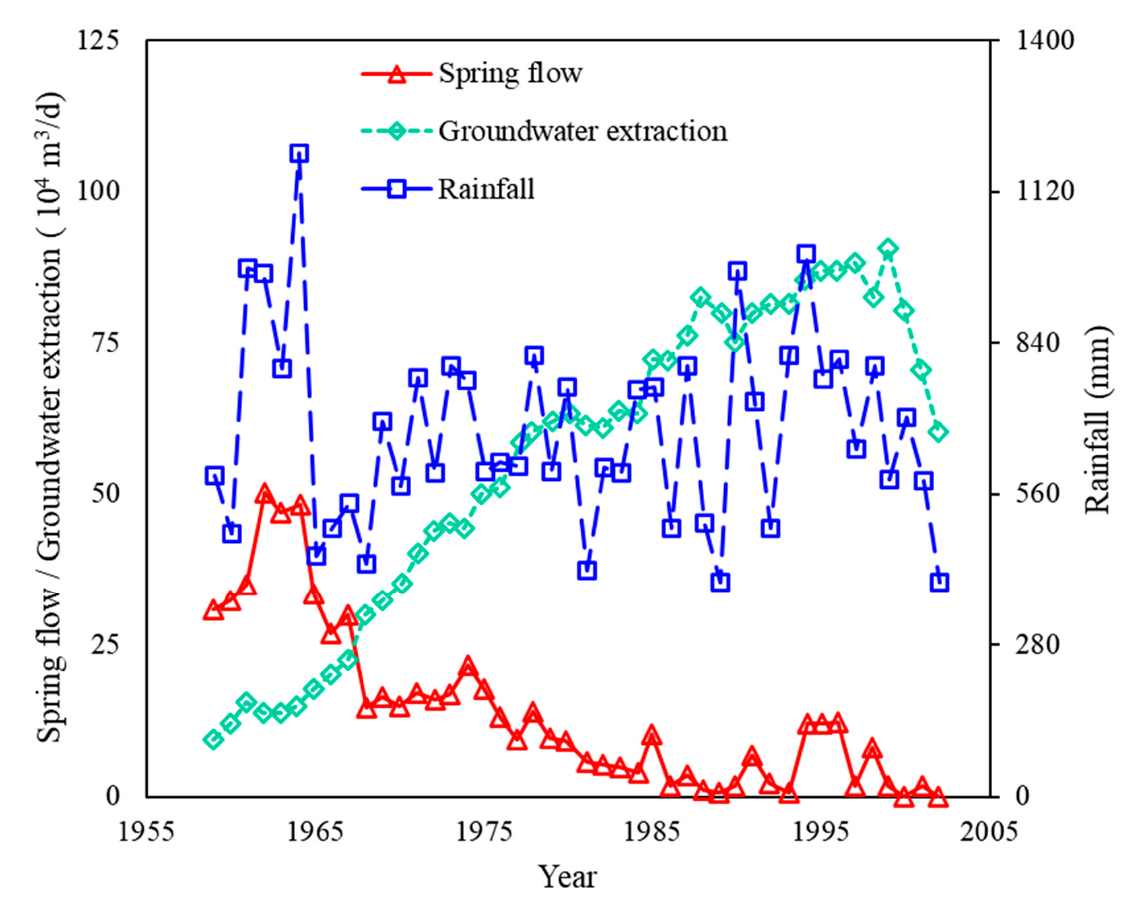
Figure 4. The relationship between spring flow, rainfall and groundwater exploitation in Jinan from 1955 to 2005 [25].